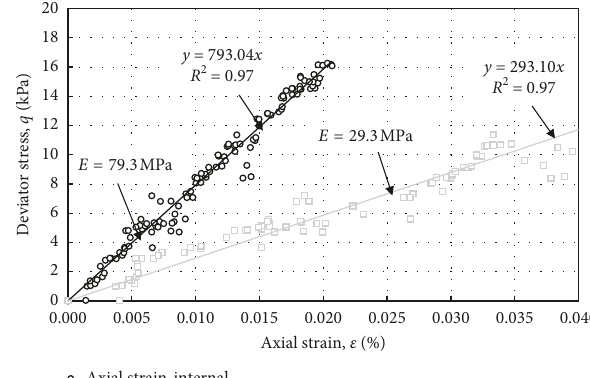
Figure 10: Response of the various transducers during K consolidation.